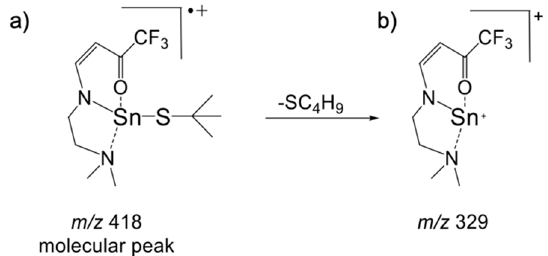
Figure 4. Scheme of the gas phase fragmentation of [ L -Sn-SC 4 H 9 ] + ( m/z = 418) ( a ) into [ L -Sn] + ( m/z 329) species ( b ) under EI-MS conditions .